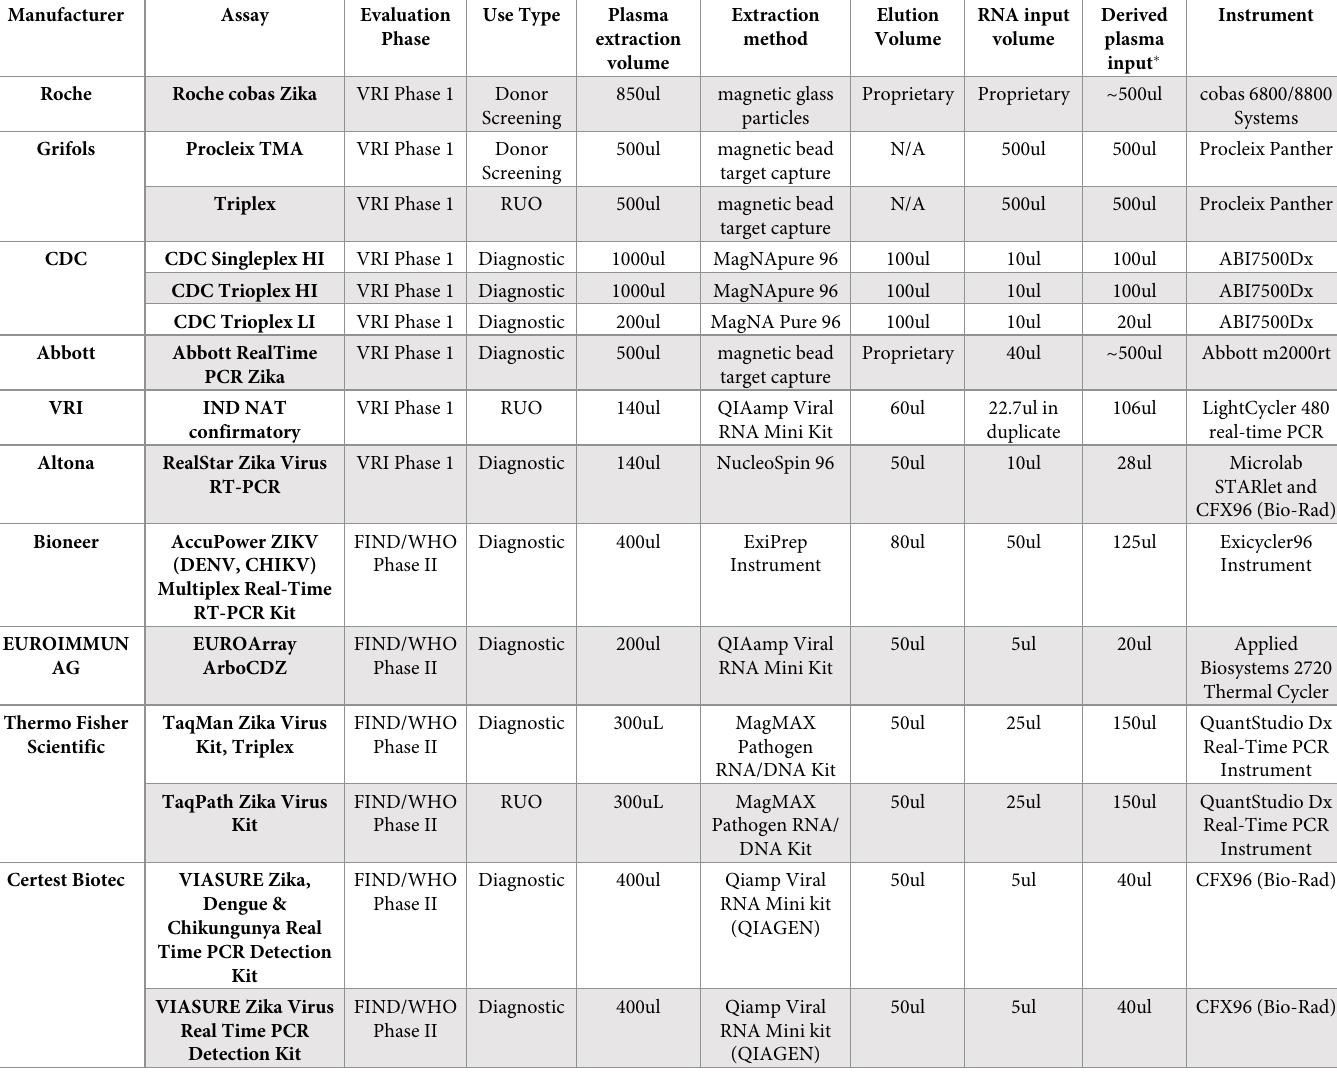
commercial laboratories experienced in performing the assays they were evaluating, in Table 1 . Results were reported to VRI for unblinding and analysis of % reactivity at each dilu- tion and probit regression analysis to estimate LOD Table 1. Summary of key characteristics, including extraction methods, input sample volumes, cutoffs values, and instruments, of the 15 assays performed at the 10 laboratories that participated in this